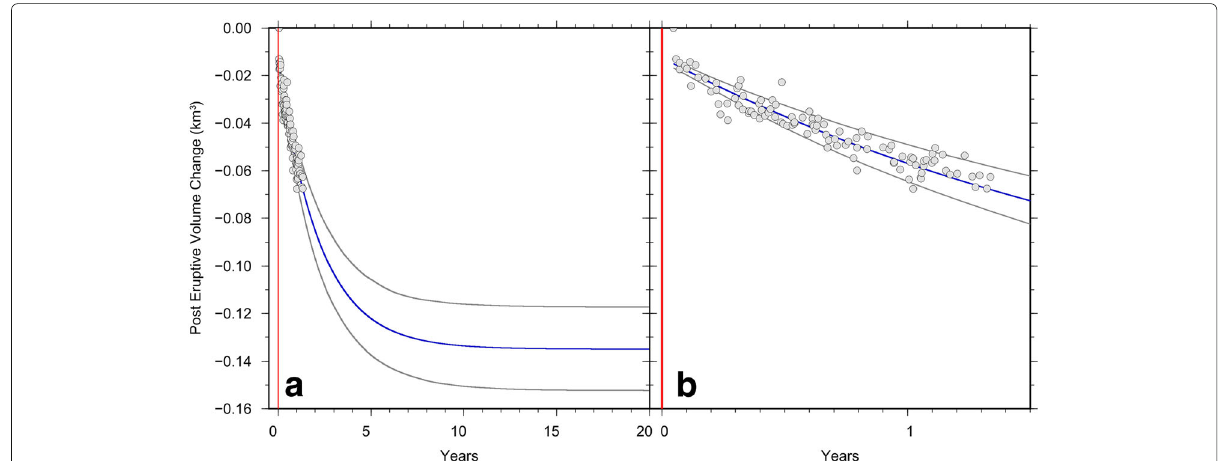
Fig. 7 Best-fit viscoelastic model (blue line) based on grid search for (cid:3) V ∞ and t R . Fitted volume change at infinite time ( (cid:3) V ∞ ) is 0.13 ± 0.01 km 3 , relaxation time t R = 2.23 ± 0.15 years. Relative to the start of the eruption (red line). Plotted with all observed data points (grey circles). The grey lines mark the upper and lower one sigma error bounds on the t R and (cid:3) V ∞ values calculated from a Monte Carlo analysis using 1000 simulations. a Viscoelastic model over a period of 20 years. b Model fit over the observation